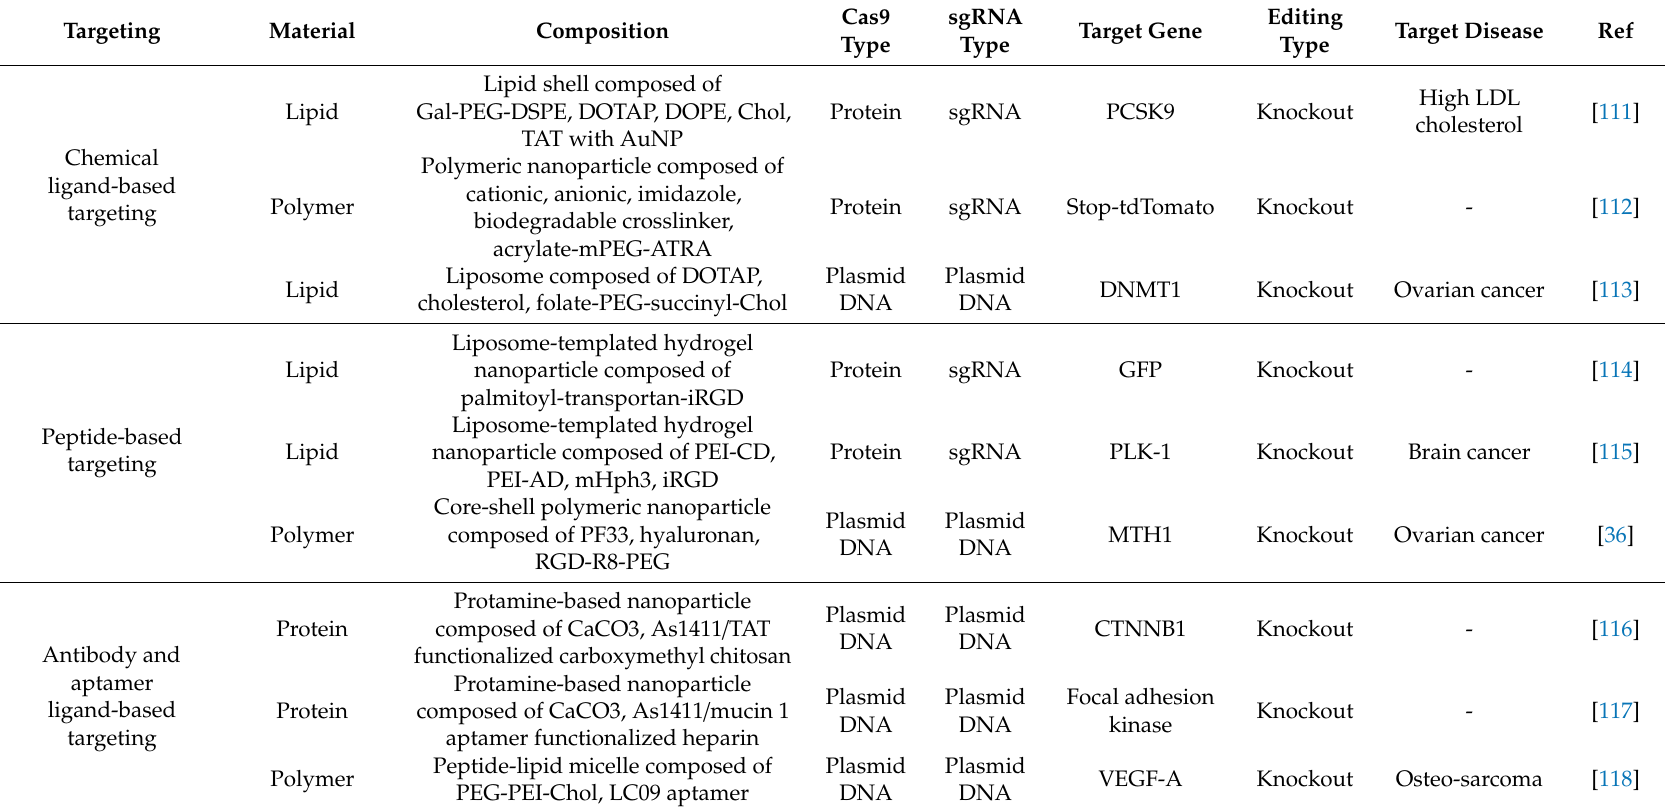
Table 2. Targeted delivery systems for genome